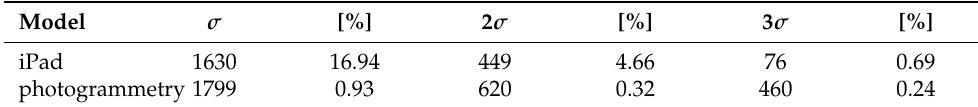
Table 4. Analysis of the number of outlying points ( σ = Q 3 = 5 [mm]) for the small architectural